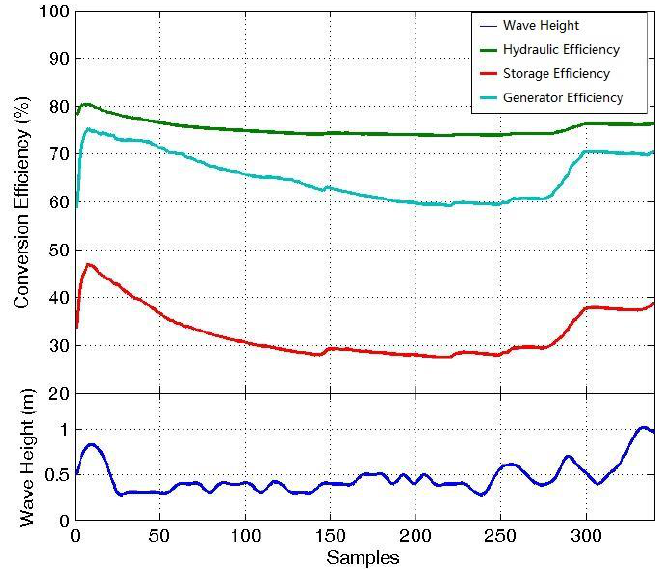
Figure 5. The comparison of different conversion efficiencies from the hydraulic system, electrical generator and electricity storage.